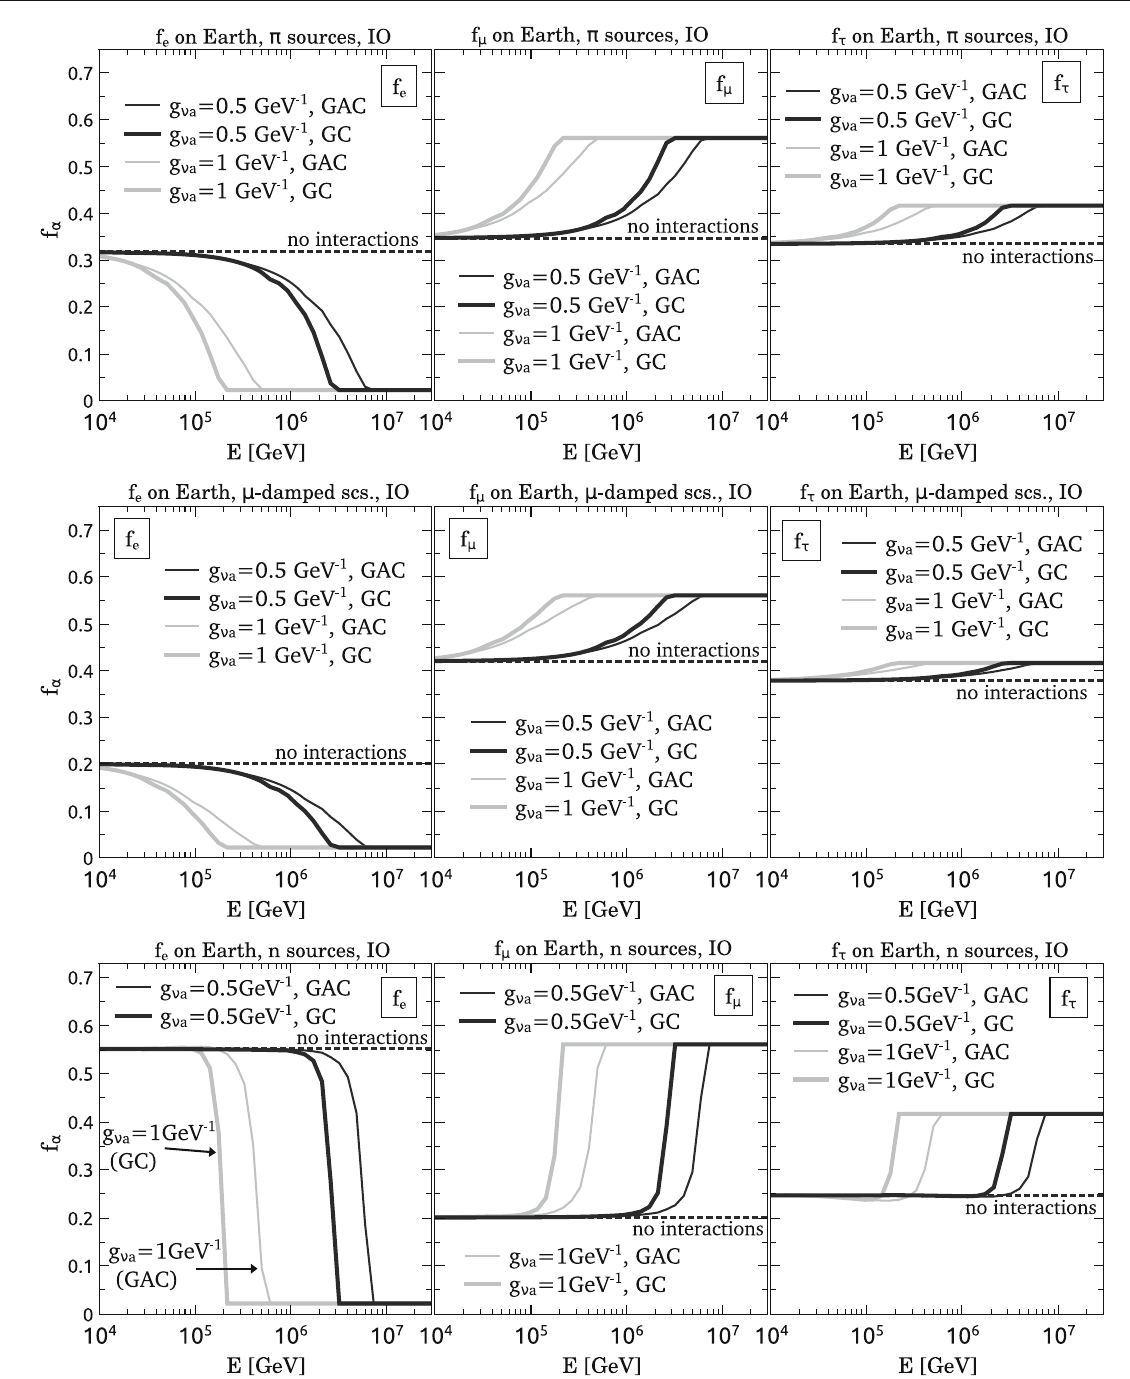
Fig. 8 Energy dependent flavor ratios of neutrinos reaching the Earth in the IO case for the electron, muon, and tau flavors in the left, center, and right panels, respectively. Thick solid lines correspond to the half of the sky centered around the galactic center (GC), while thin lines cor-